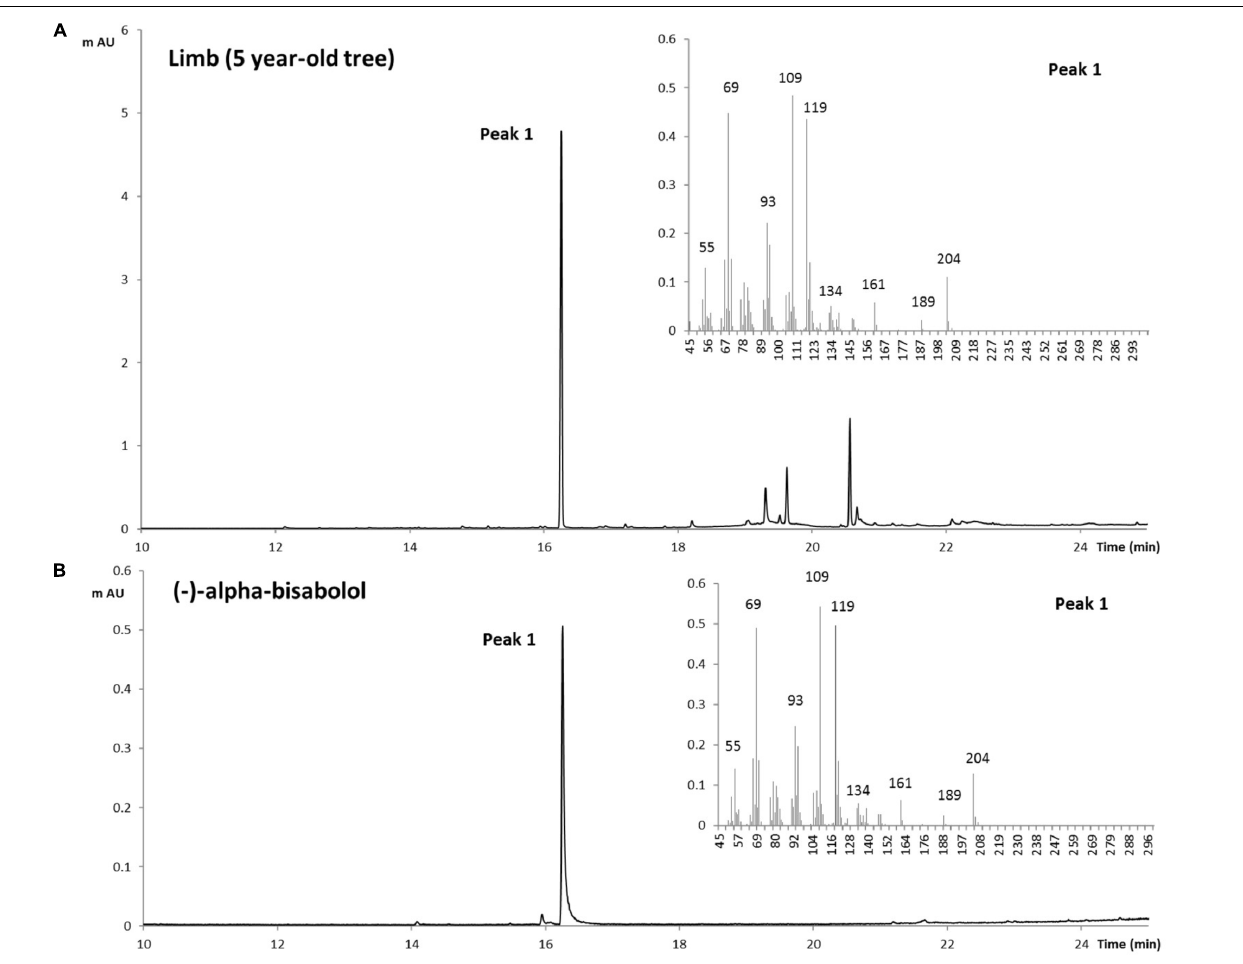
FIGURE 2 | Identification of (–)- α -Bisabolol in Candeia. Extract from the limb of Candeia tree (5 years) was obtained with dichloromethane then analyzed by GC-MS (A) , and compared to a standard of (–)- α -Bisabolol (B) . On the right side of both panels are the MS spectra for the peak number 1.